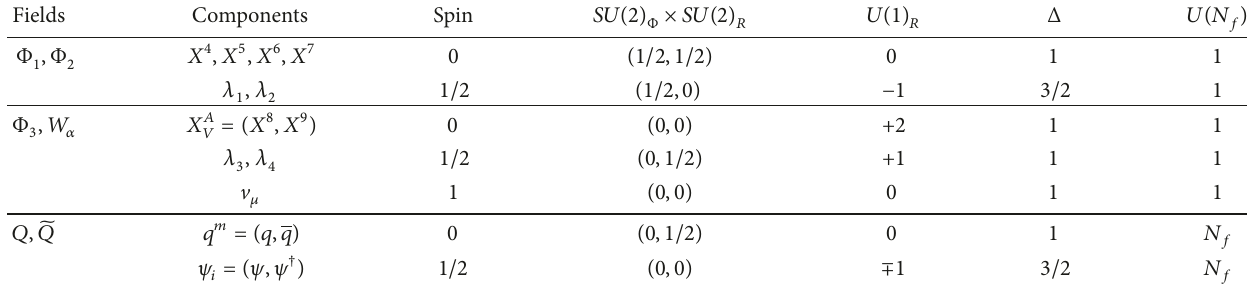
Table 1: Degrees of freedom in the dual field